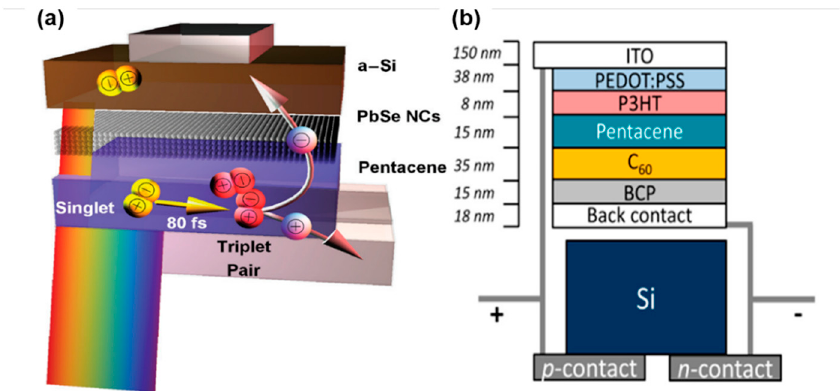
Figure 15. ( a ) Pentacene/PbSe/a − Si device structure and proposed working mechanism. ( b ) Device architecture of the parallel tandem cell. Reprinted with permission from Ref. [97] and Ref. [98]. Cop- yright 2012, AIP Publishing and 2017, American Chemical Society, respectively.